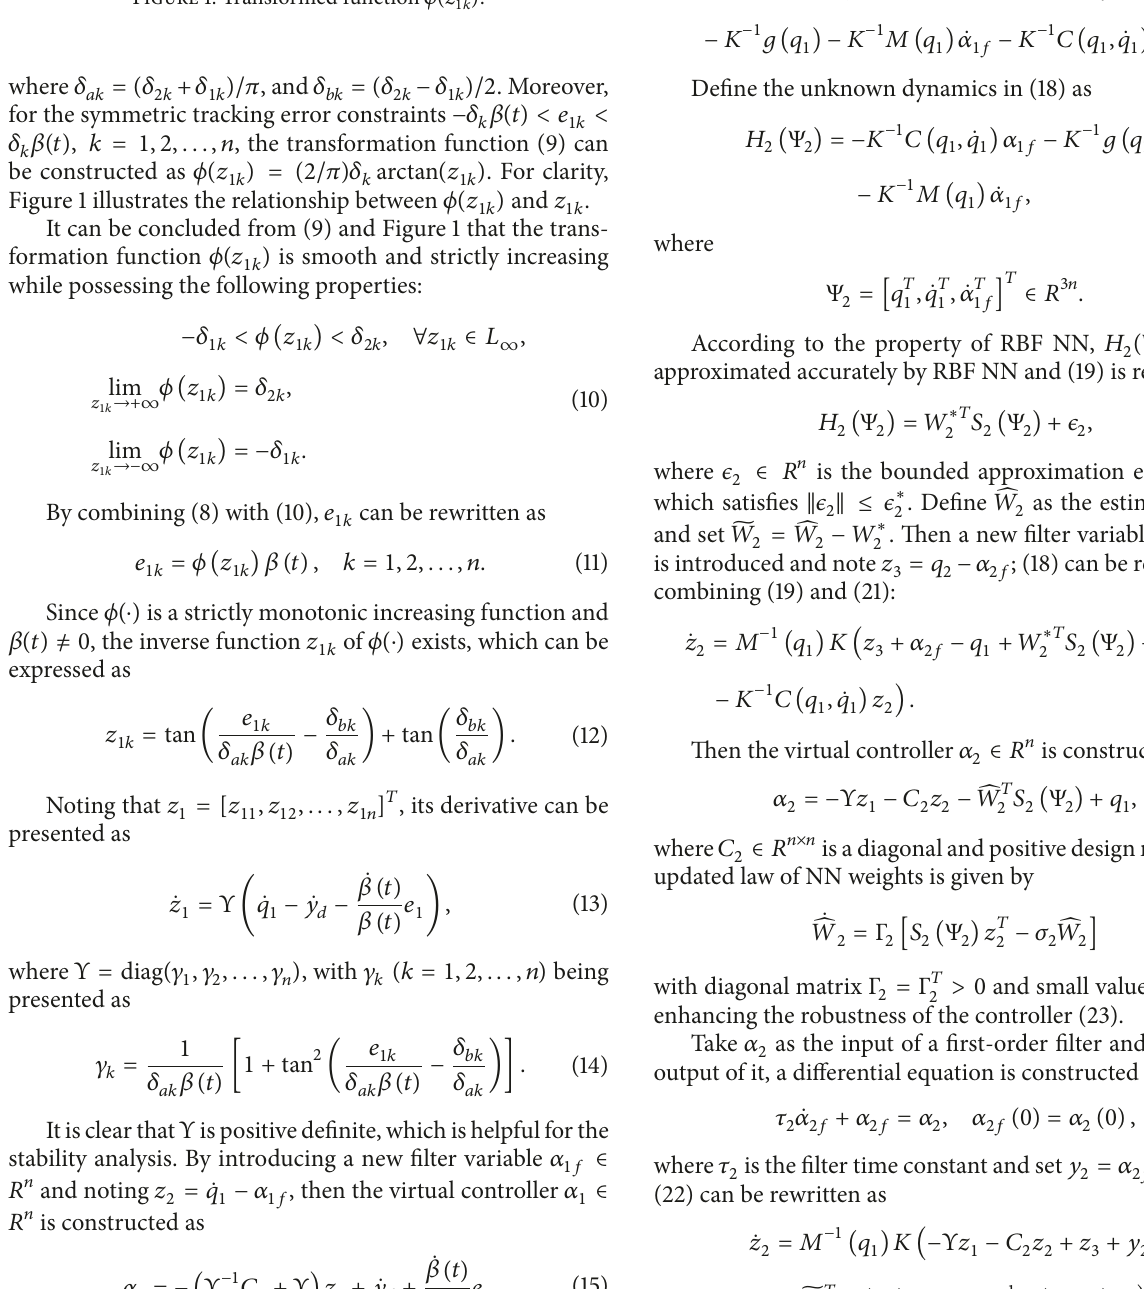
Figure 1: Transformed function 𝜙(𝑧 1𝑘 )